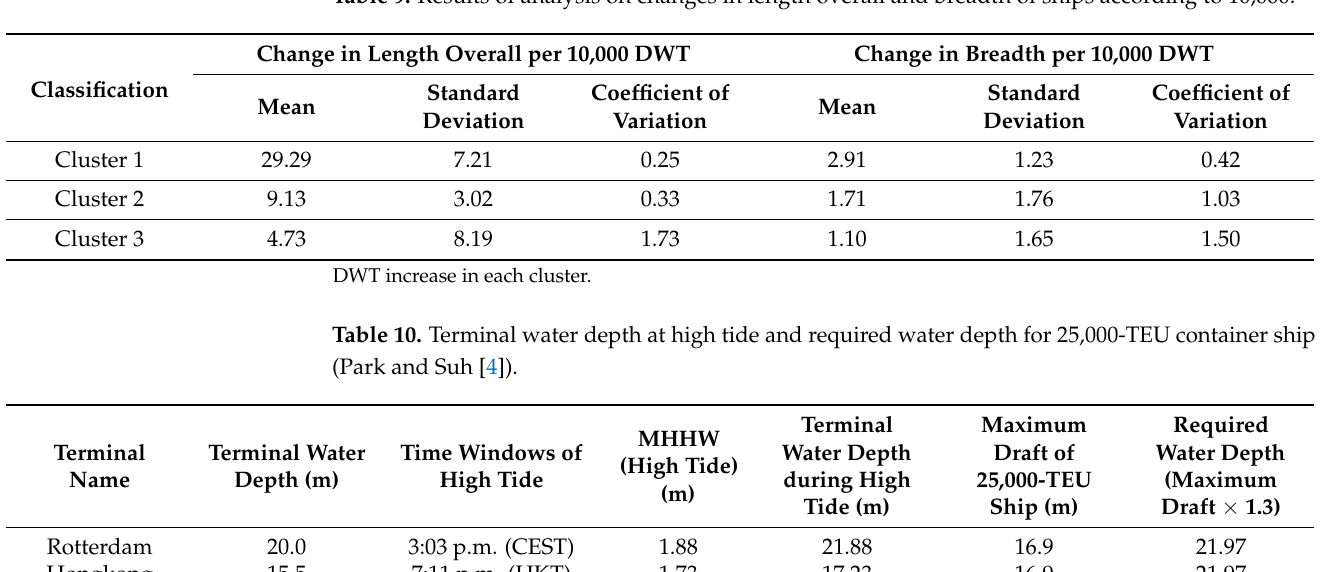
Table 9. Results of analysis on changes in length overall and breadth of ships according to 10,000.